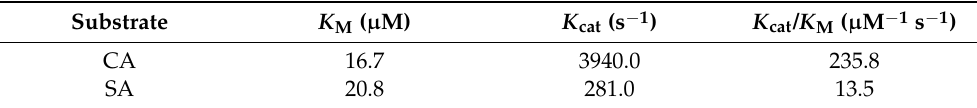
Table 5. Apparent K M , K cat and K cat / K M values for coniferyl alcohol (CA) and sinapyl alcohol (SA) shown by